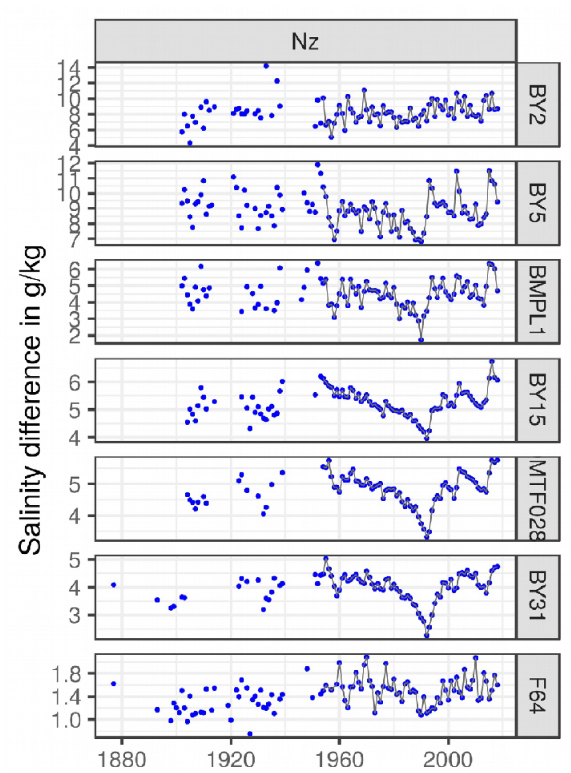
Figure 22. Difference between bottom and surface salinity as a measure for the vertical stratification (blue dots) during 1877–2018. Only time steps when both values were available are considered. The grey lines show the period when every station has data for ev- ery year (1954–2018).